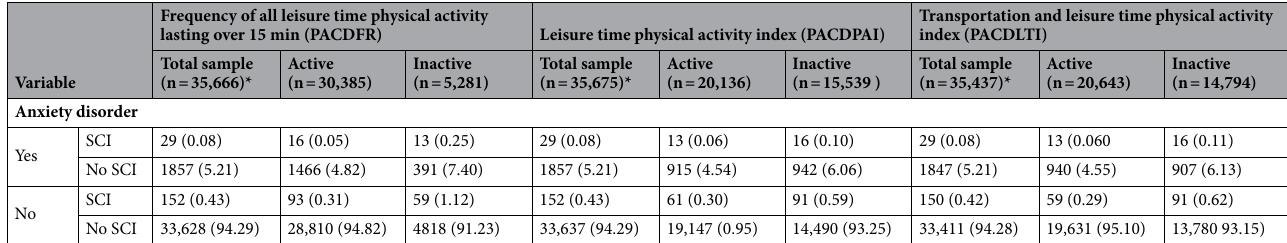
Table 2. Characteristics of the population-based survey by physical activity status following adjustments to confounders. Data are sample sizes (percentages). Percentages are probability-weighted. SCI spinal cord